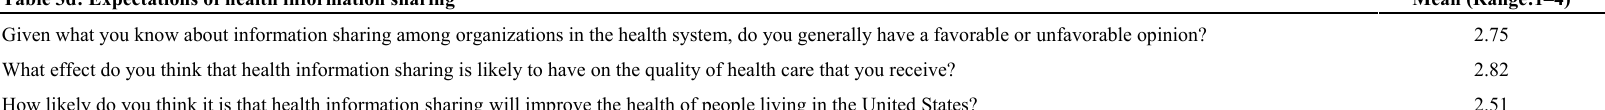
Table 3e: Psychosocial factors Mean (Range:1–4) β' R 2